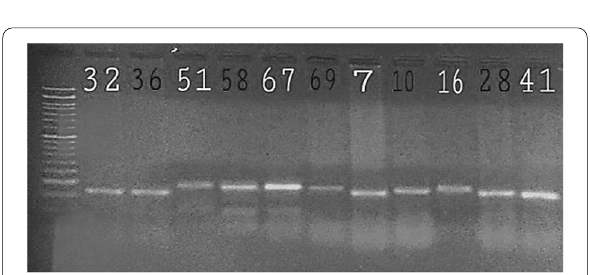
Fig. 6. Three percent UltraPure Agarose gel belonging to monomorph alleles after digestion (CAPS-SSR). Ladder 50 bp was used